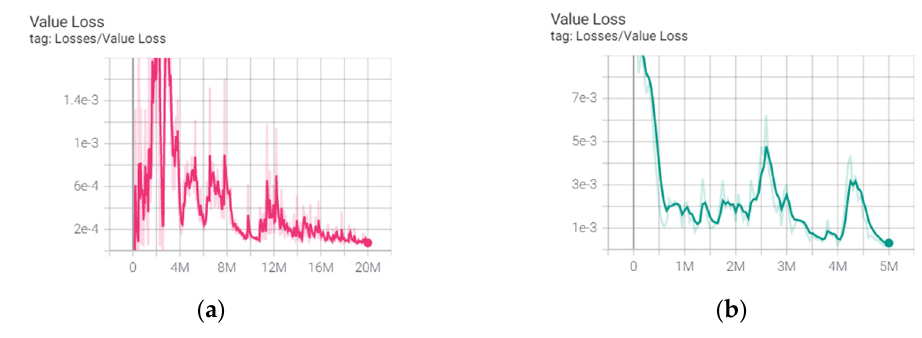
Figure 9. V(s) graph evaluated by critic during learning: ( a ) Random RL and ( b ) ILFAS RL. Random RL graph looks sharper because of the long learning time. Nevertheless, the ILFAS graph shows a quick convergence even in a small episode. The graph converging in a short learning time demonstrates that transfer learning is properly implemented. (Unit: value loss/learning steps.).